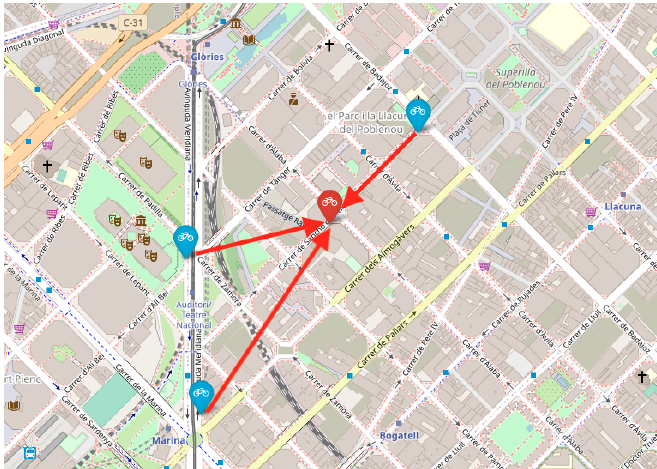
Figure 2. Example of local rebalancing. The extracted rule r contains 4 stations: 3 in the body of the rule and 1 in the head. Blue stations are positively critical; the red station is negatively critical. Once such pattern is detected in the new batch of data B , the frameworks suggests to move bicycles from blue stations to the red stations such that the final occupancy rate of the 4 stations is the